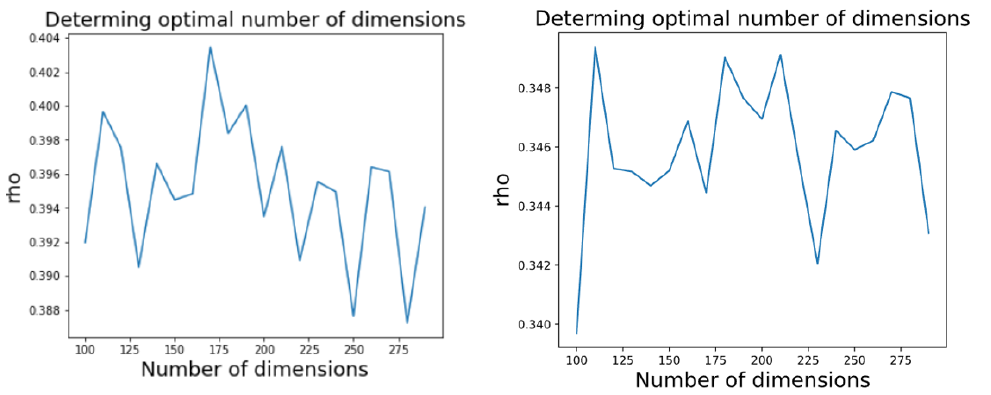
Figure 10. Dimension for Word2Vec on the left and FastText on the